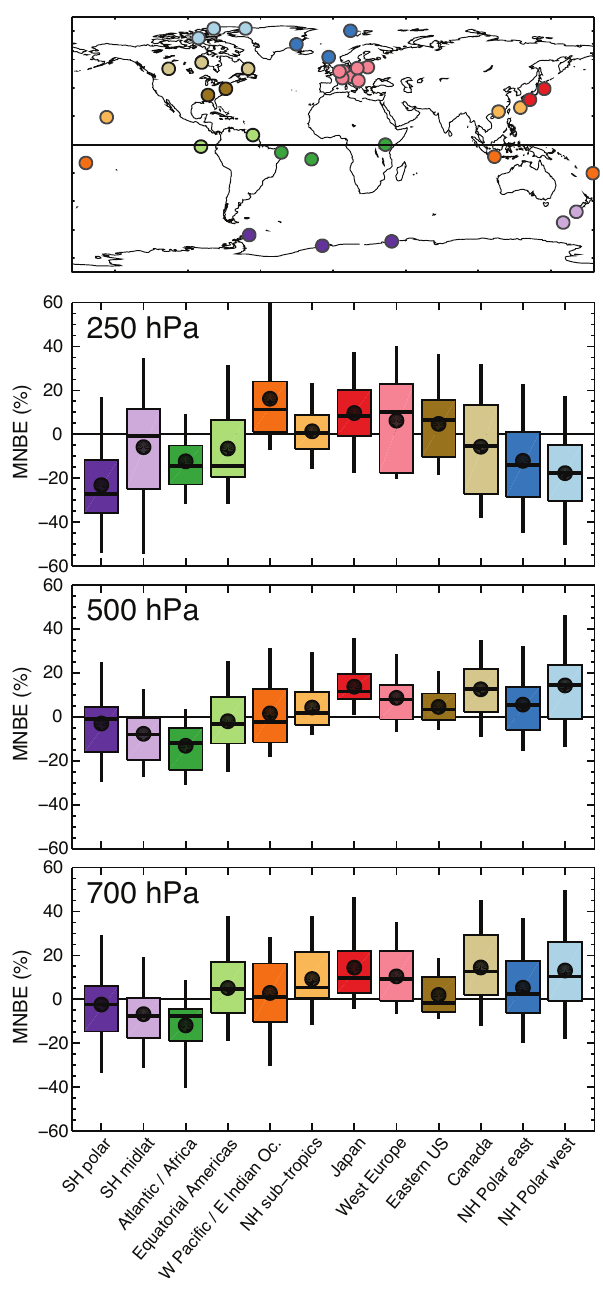
Fig. 5. Normalised biases for the ACCMIP models (Hist 2000 simu- lation) against the ozonesonde measurements compiled into regions by Tilmes et al. (2012). Each region is colour-coded, and the con- stituent ozonesonde sites are indicated in the top panel. Biases are shown for (bottom to top) 750, 500 and 250hPa. The box, whiskers, line and dot show the interquartile range, full range, median and mean biases respectively, in a similar style to Fig. 1. The y-axis has the same scale in each